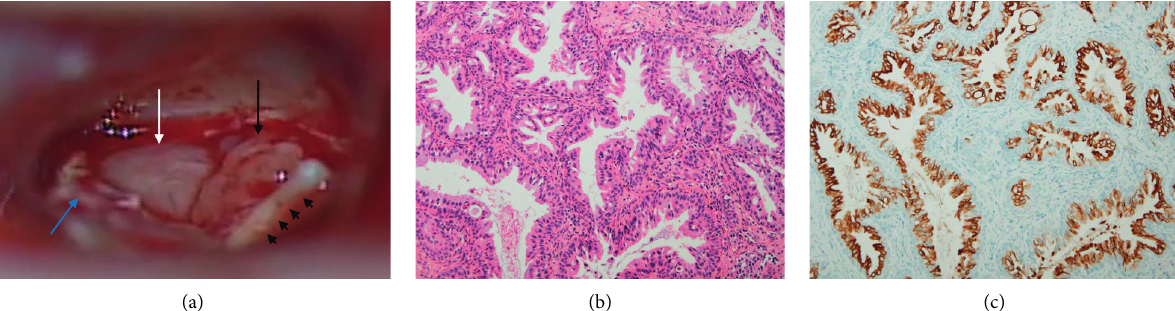
Figure 2: (a) A nonencapsulated, polypoid, pinkish mass (black arrow) and gray-colored mass with fibrotic consistency (white arrow) were seen in the anterior part of the tympanic cavity. Black arrow heads, malleus handle; blue arrow, tympanomeatal flap. (b) Tubular tumor cell structures with intervening bands of tumor stroma are observed, hematoxylin-eosin X100. (c) Immunohistochemical staining for cyto- keratin 7 was positive in luminal cells,